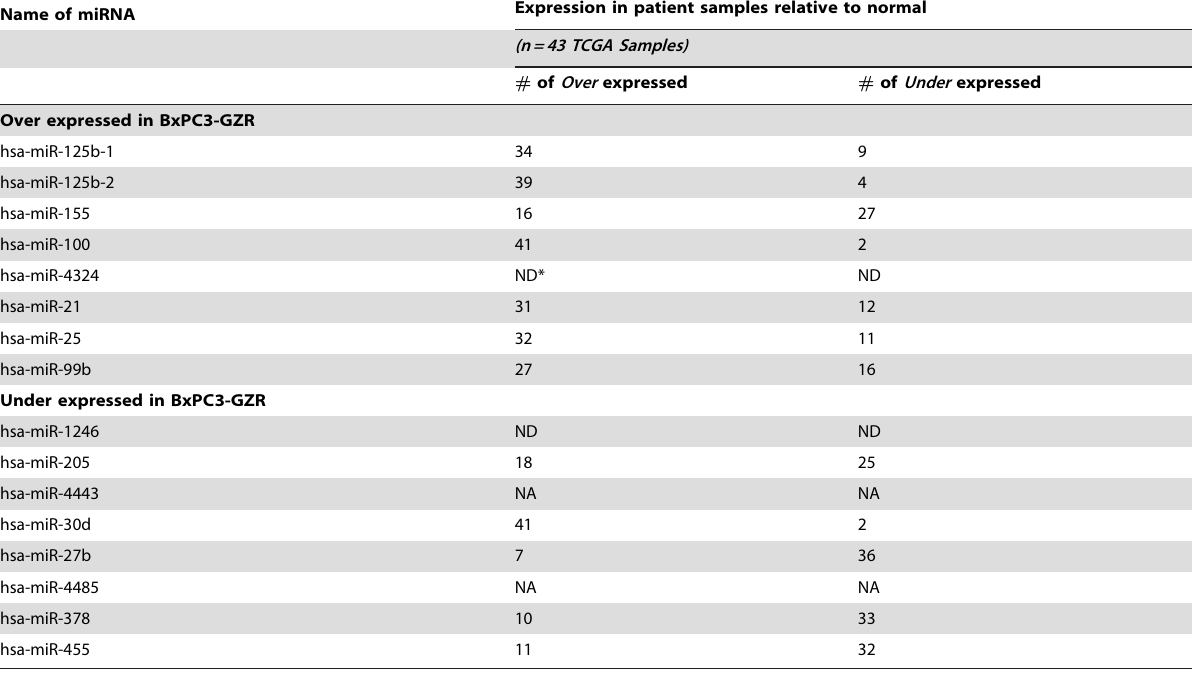
Name of miRNA Expression in patient samples relative to